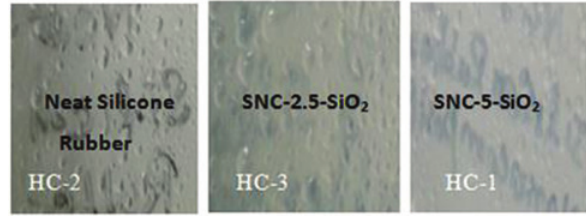
Figure 4: Photographs at the start of experiment for STRI hydropho- bicity classification.